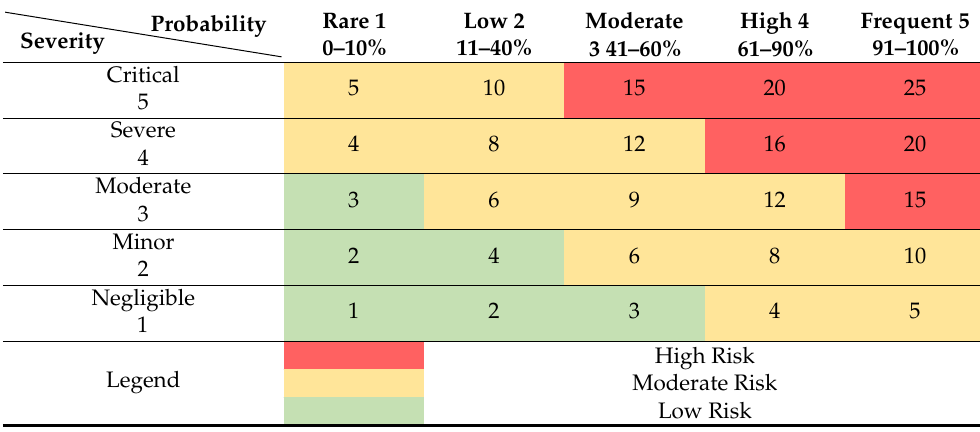
Table 3. Grading scale of maintenance of educational buildings systems.